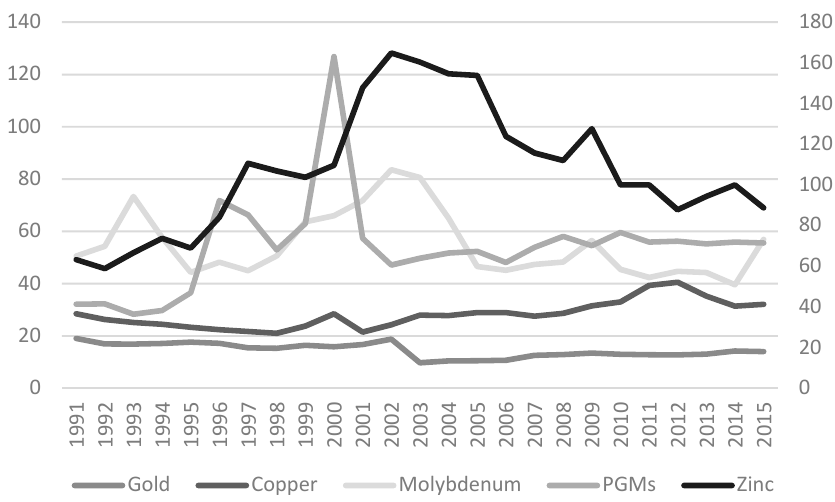
Figure 7. Scarcity of minerals, according to their R/P ratios (1991–2015); Source: Authors’ own estimations based on [46].